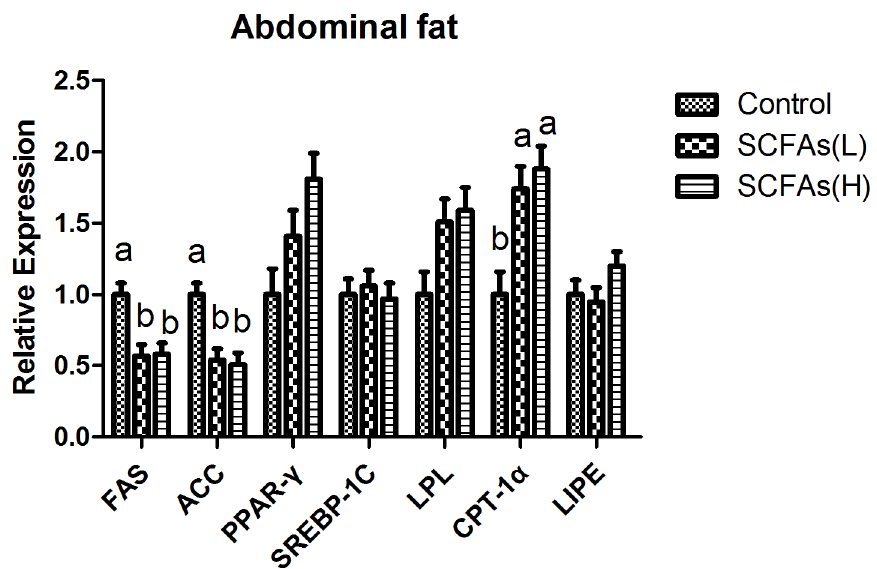
Fig 3. Effects of SCFAs on mRNA expressions for key factors related to lipid metabolism in abdominal fat over the experimental period of weaned pigs. SCFAs (L): acetic acid 20.04 mM, propionic acid 7.71 mM and butyric acid 4.89 mM; SCFAs (H) :acetic acid 40.08 mM, propionic acid 15.42 mM and butyric acid 9.78 mM. FAS fatty acid synthase; ACC acetyl-CoA carboxylase; PPAR peroxisome proliferator activated receptor; SREBP-1C sterol regulatory element binding protein 1C; LPL lipoprotein lipase; CPT-1 α carnitine palmitoyltransferase-1 α ;LIPE lipase hormone- sensitive. a-b Within a row, means without a common superscript differ (P < 0.05).